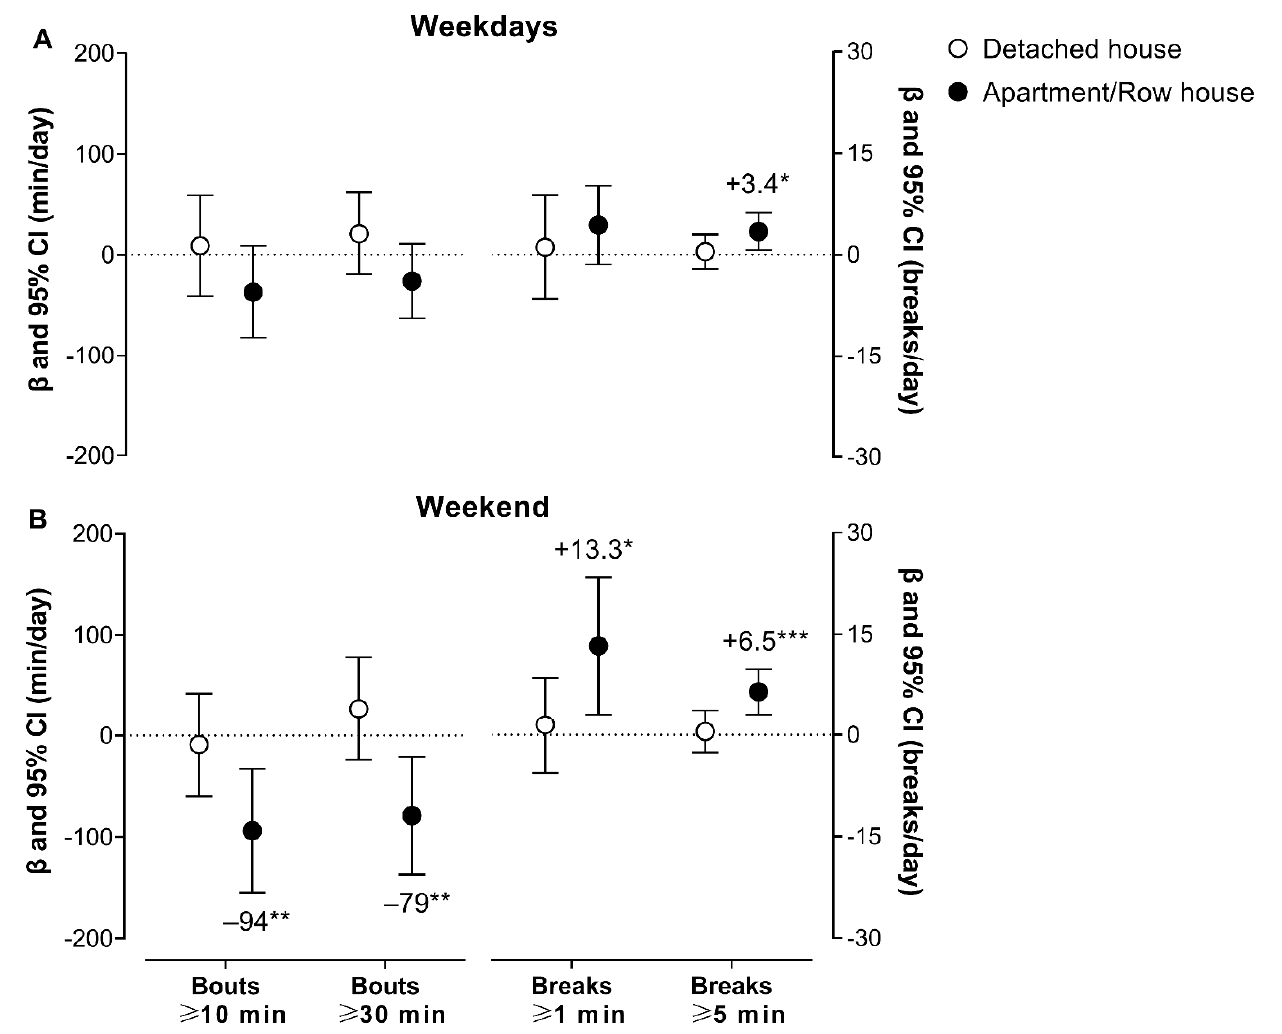
Figure 3. Changes in sedentary bouts and breaks on weekdays (panel A ) and on the weekend (panel B ) after COVID-19 vaccination among 32 older adults with hypertension residing in a detached house ( n = 17) or apartment/row housing ( n = 15). Values are expressed as contrast estimates ( β ) and the 95% Wald confidence interval (CI) of the estimated marginal mean (EMM) (contrast = EMM of after—EMM of before COVID-19 vaccination). The models were analyzed using a generalized linear mixed model controlling for the daily accelerometer wearing time. * p < 0.05; ** p < 0.01; *** p < 0.001.